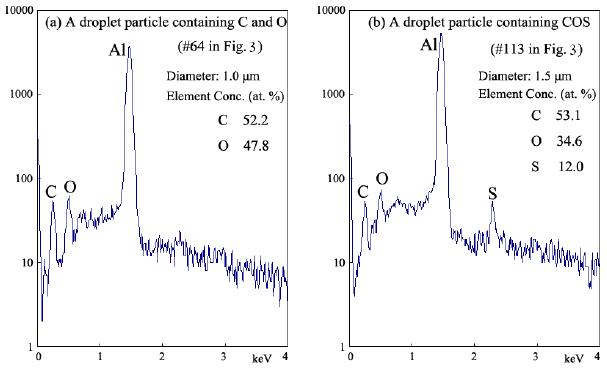
26 Fig. 5. X-ray spectra and atomic concentrations of organic carbon (OC) particles Fig. 5. X-ray spectra and atomic concentrations of organic carbon (Al X-ray peaks are from collecting substrates) (OC) particles (Al X-ray peaks are from collecting